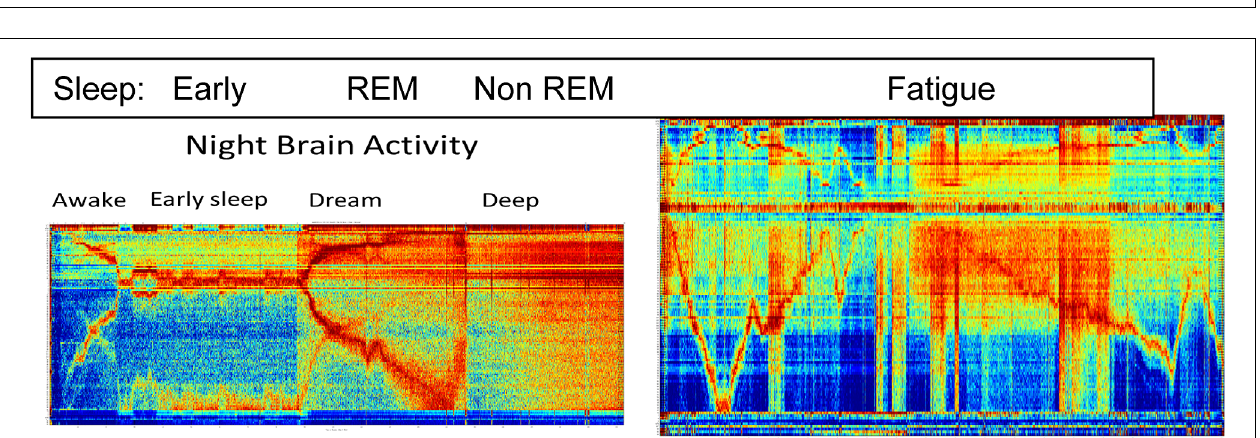
FIGURE 2 |Three different brain states based on the brain activity features found by Intrator (2014).